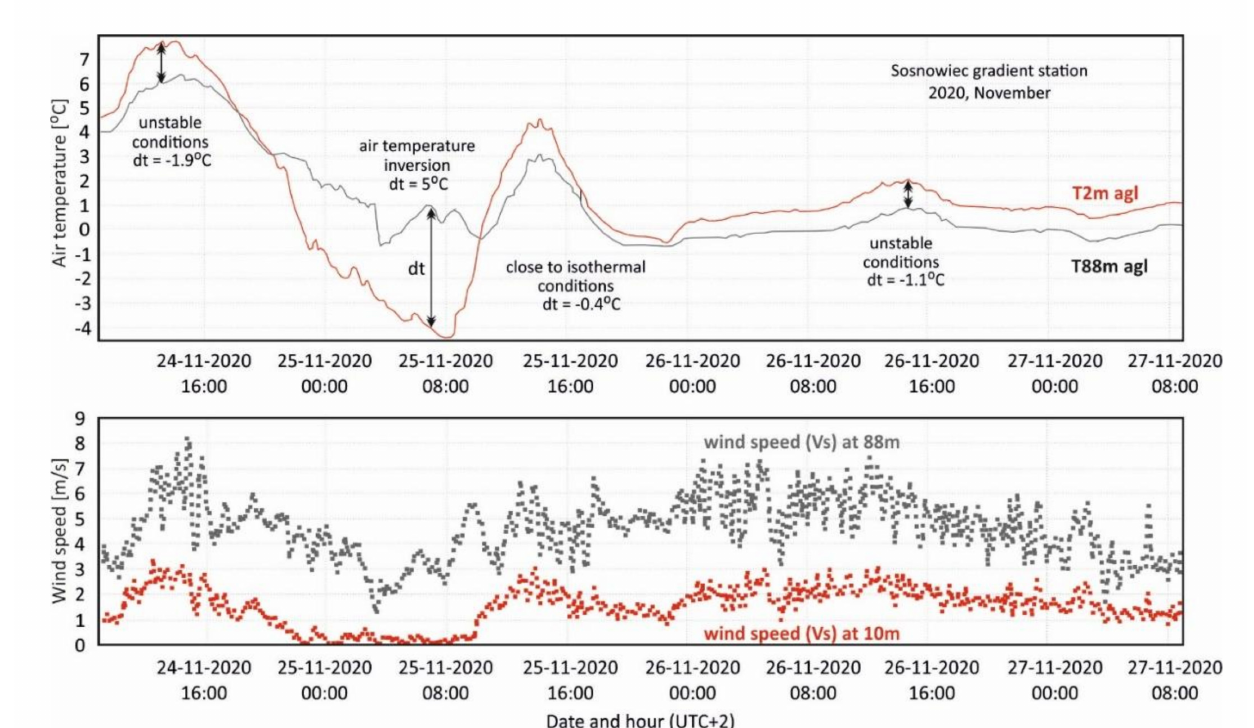
Figure 2. Daily course of air temperature (upper graph) and wind speed vs. (lower graph) at gradient meteorological station between 24 November 2020 16:00 (UTC+2) and 27 November 2020 08:00 (UTC+2) showing various air temperature differences (dt = T88 − T2) that determines the thermodynamic state of the